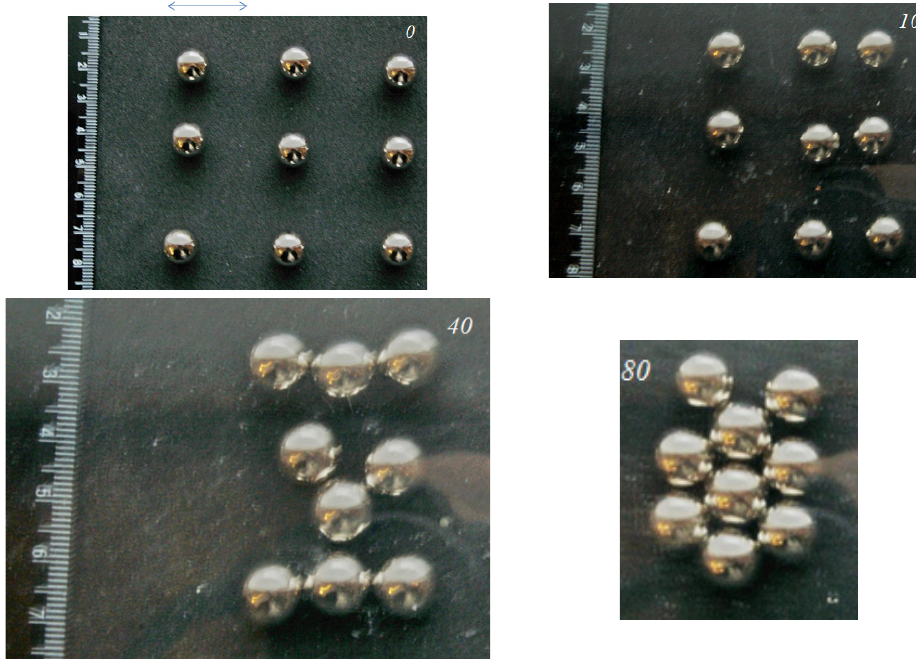
Figure 6. Nine balls at an initial distance of 30 mm from each other.